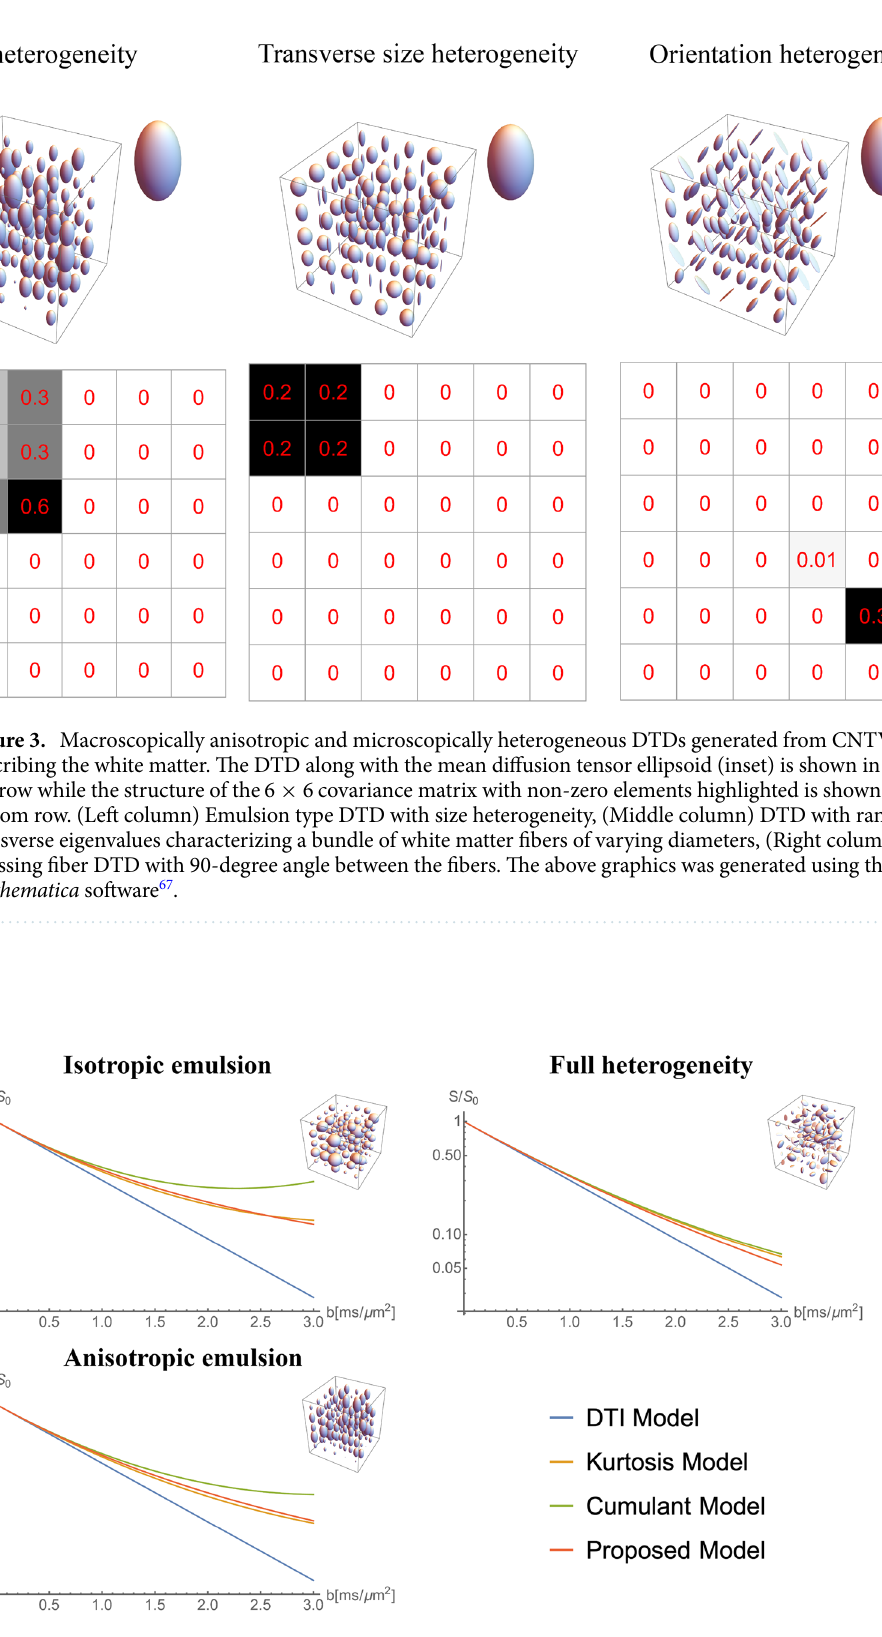
Figure 4. Comparison of signal models (DTI, kurtosis, second order cumulant and proposed model) for DTDs shown in the inset generated from CNTVD. Normalized MR signal S / S 0 is plotted for various b-values from rank-2 b-matrices with fixed shape and orientation. The above graphics was generated using the Mathematica software 67